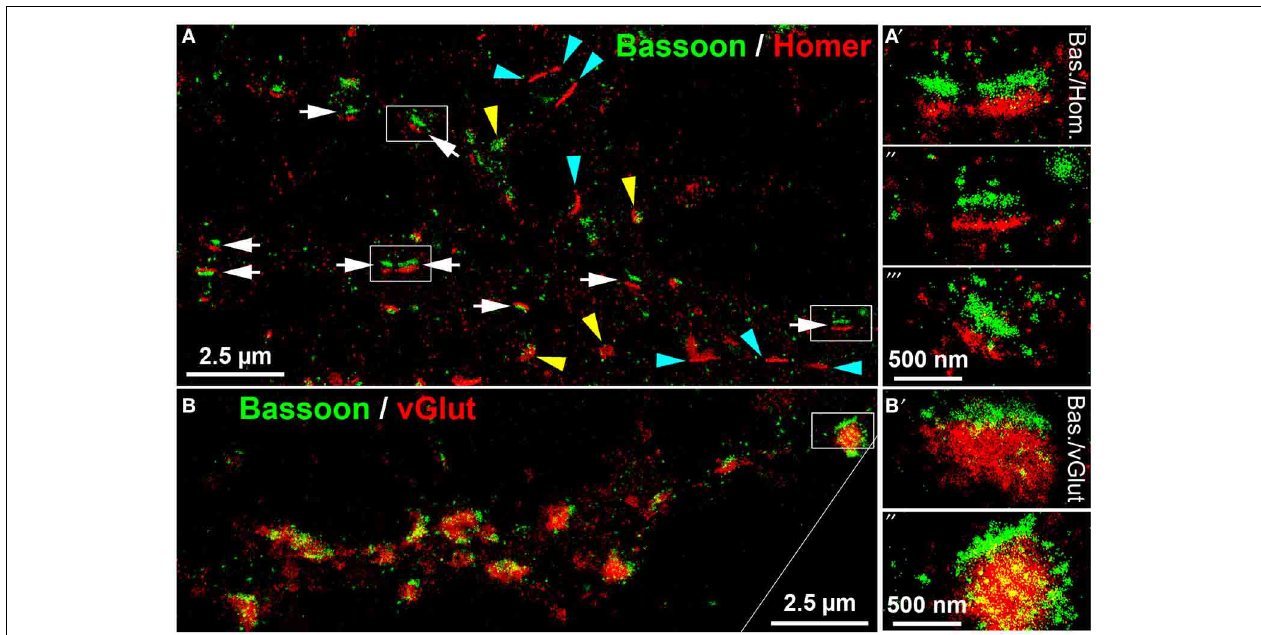
FIGURE 5 | d STORM images of Bassoon, Homer and vGluT reveal hallmarks of mature synaptic structures in long-term cultured hippocampal neurons. (A) Presynaptic Bassoon and postsynaptic Homer1 clusters formed well-separated juxtaposed synaptic bar structures (white arrows) in mouse hippocampal neurons (DIV 35). Elliptical disk-like clusters of Homer1 and Bassoon may represent a “face orientation” of synapses (yellow